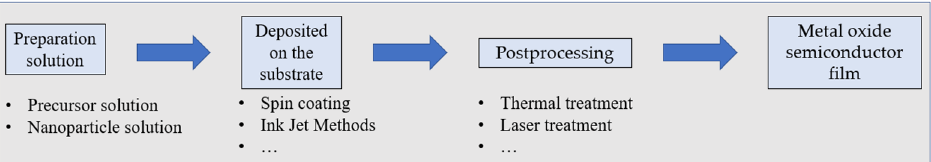
Figure 2. Schematic diagram indicating a typical solution process synthesis of metal oxide semicon- ductor thin films and the corresponding TFT devices.